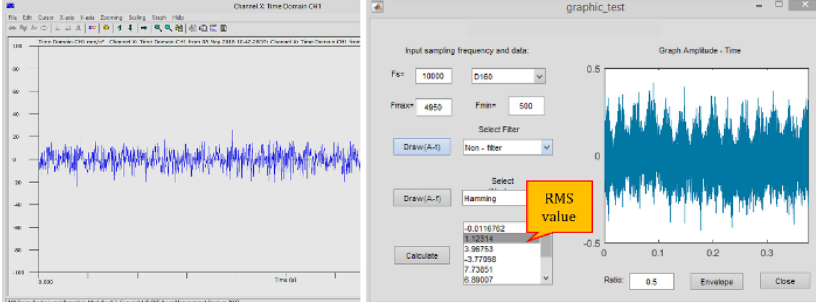
Fig. 4. RMS value when measuring vibration acceleration.